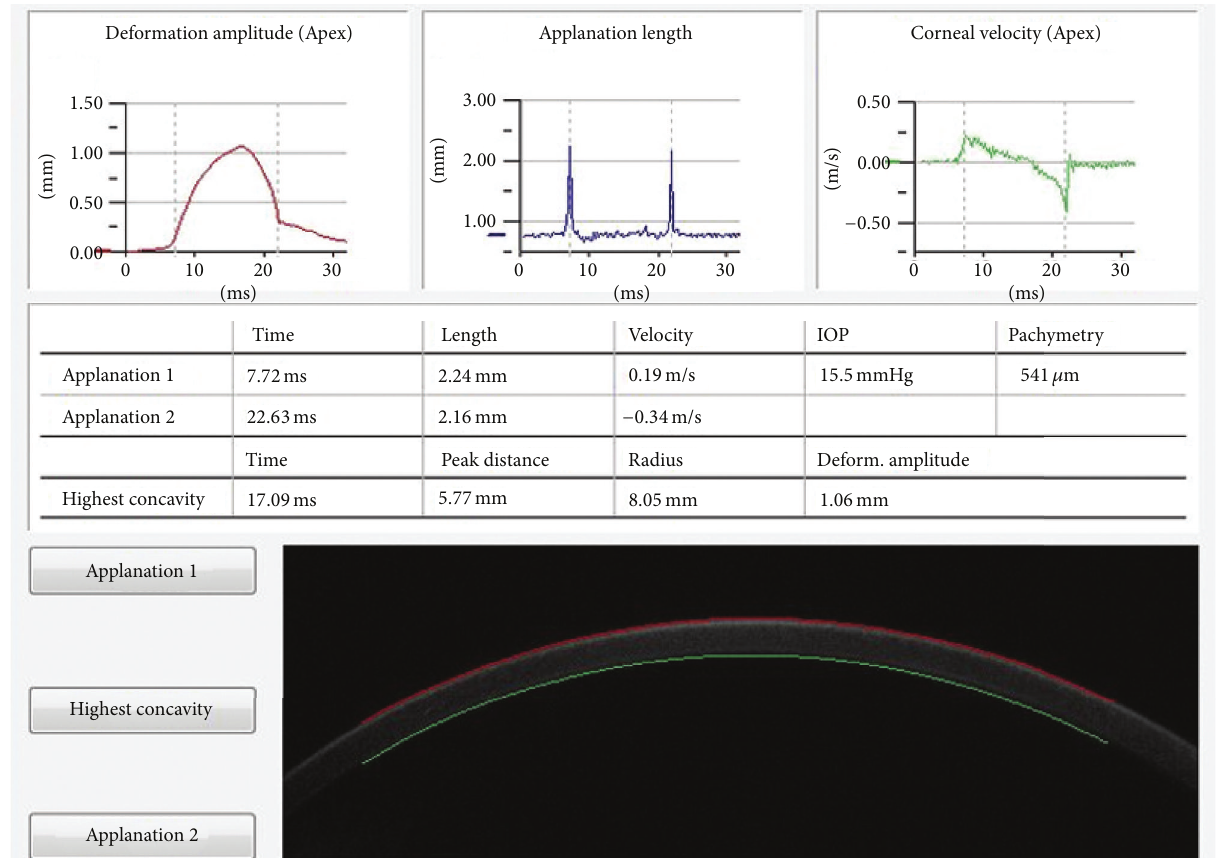
Figure 2: Corvis ST output. The output includes the IOP, CCT, and corneal biomechanical characteristics (applanation time, length, and velocity, time to the highest concavity and curvature radius, peak distance, and deformation